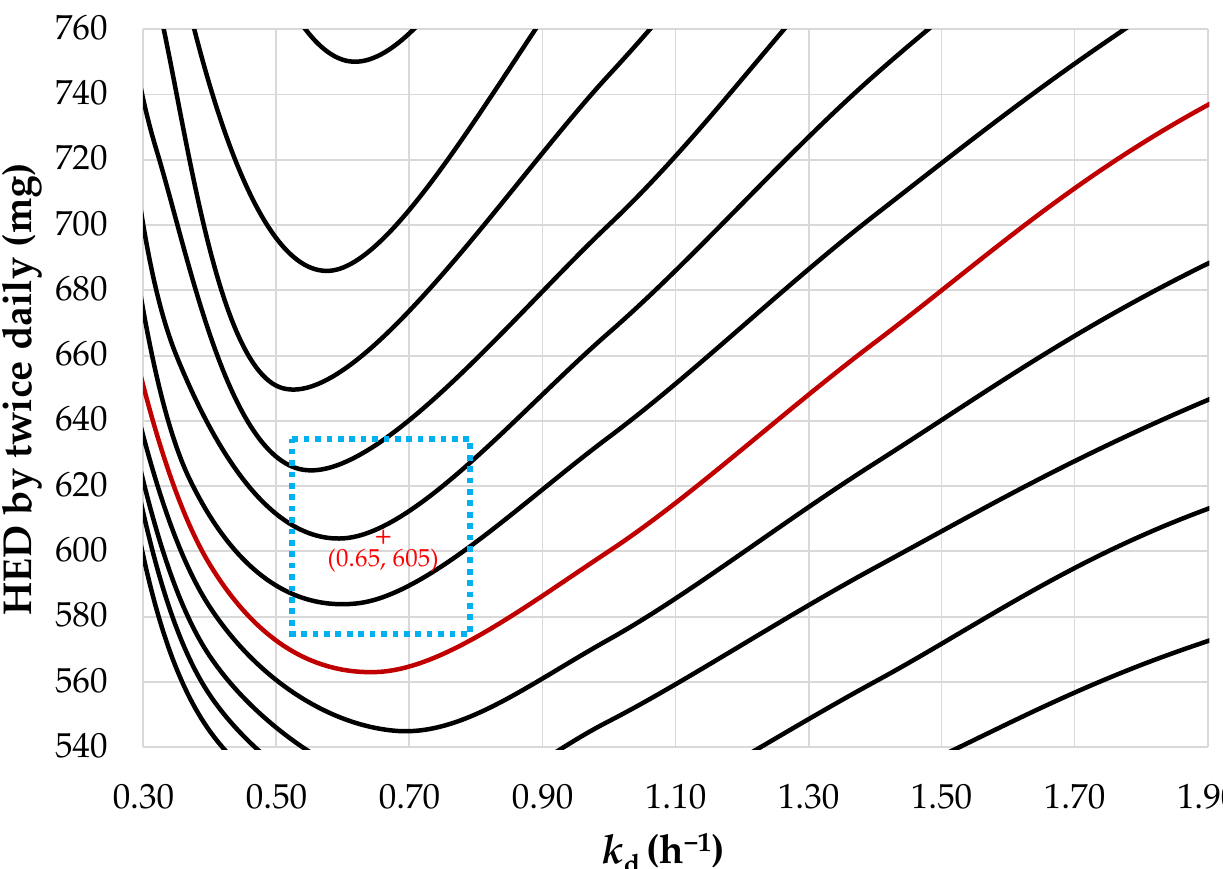
Figure 6. A contour plot of the pharmacokinetic efficacy index ( t >MEC ) corresponding to constants of dissolution ( k d ) and human equivalent dose (HED). The red curve represents the t >MEC of 12.8 h, which the SR dosage form requires to exceed for a consistent or higher efficacy of the drug product. The blue dotted-line area is as an example as the acceptable specification of the target drug product.